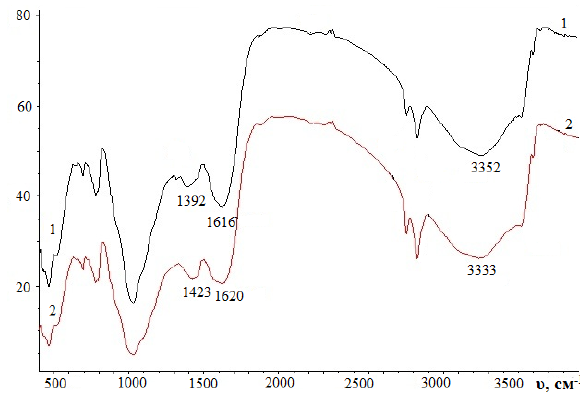
Figure 8: IR-spectrum of humic sorbent: 1 - before sorption; 2 - after sorption of nickel